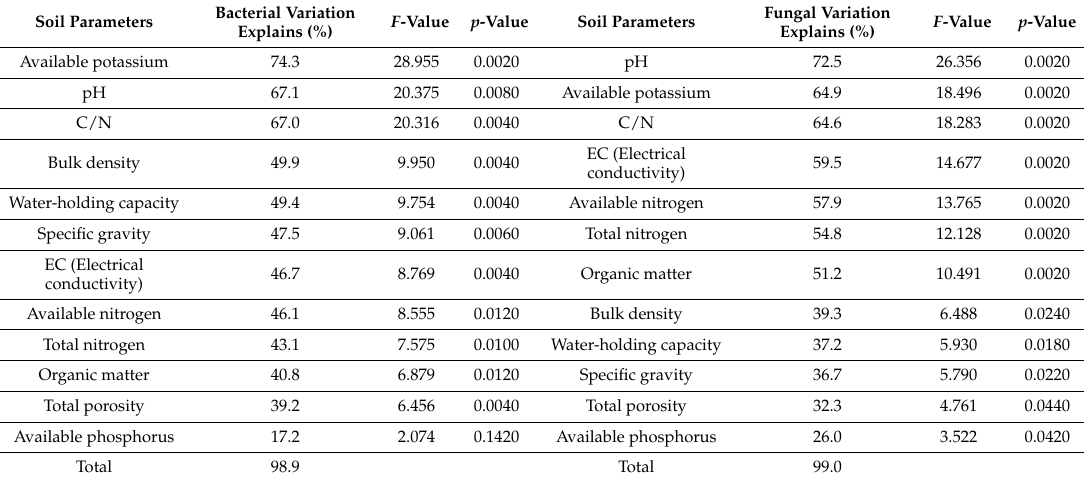
Table 4. Results of the Monte Carlo permutation test for bacterial and fungal community variation explained by soil physicochemical